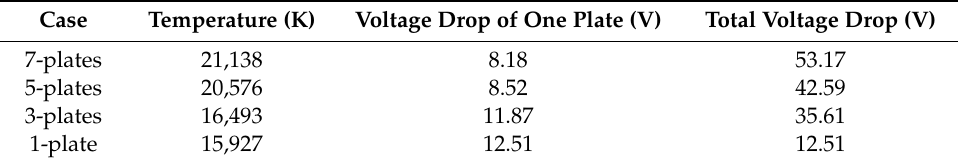
Table 1. Voltage drop of splitter plate change